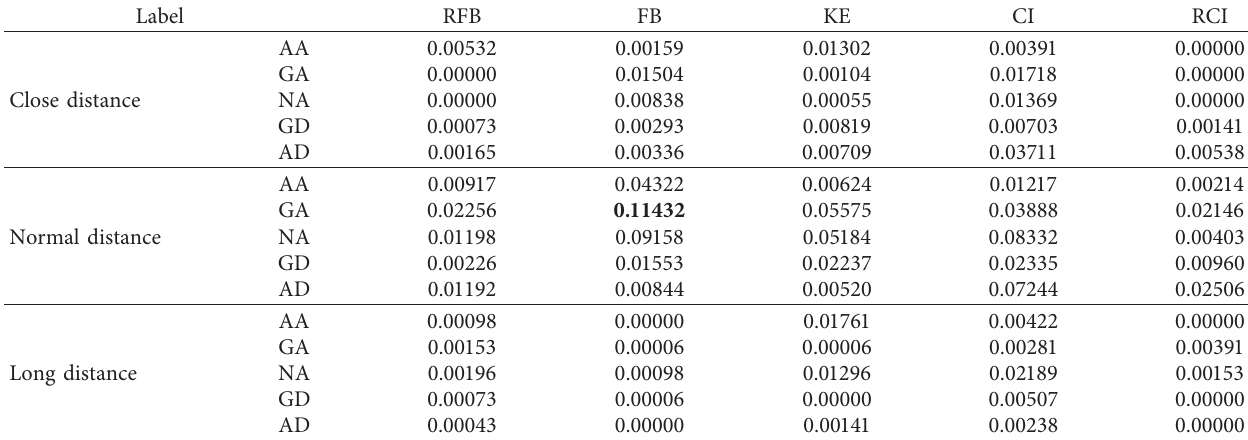
Table 3: Normalized frequency distributions of driving patterns for driver